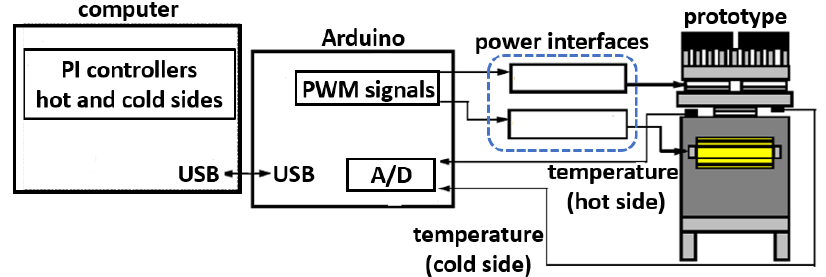
Figure 9. Block diagram of the implemented closed-loop control